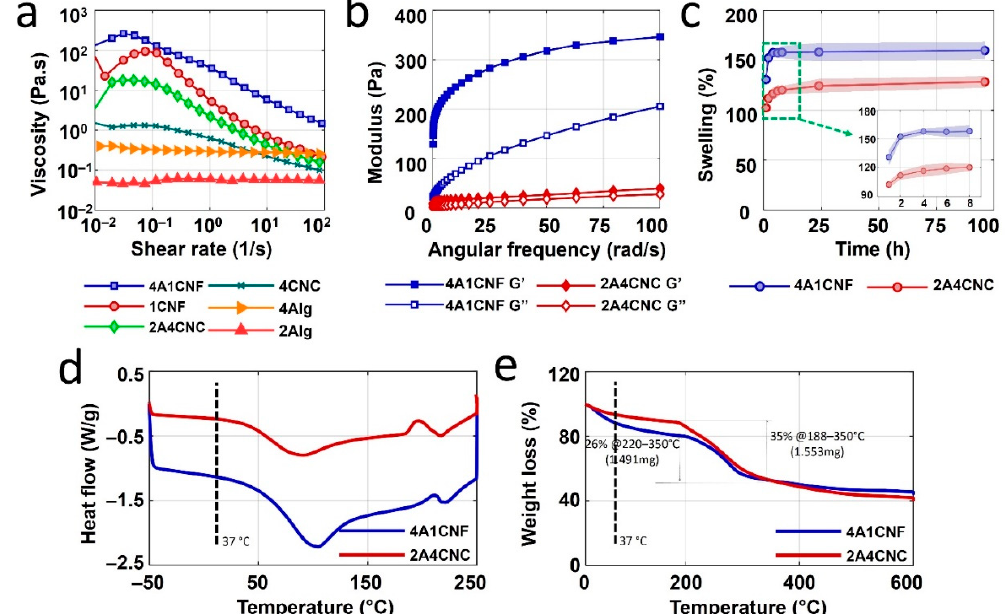
Figure 3. Rheological and thermal characterization of bioinks. ( a ) The viscosity of two hybrid bioinks formulation (4A1CNF, 2A4CNC) and their separate components (4A, 1CNF, 2A, and 4CNC) as a function of shear rate. ( b ) Storage modulus (G’) and loss modulus (G’’) of two bioink formulations (4A1CNF and 2A4CNC). ( c ) Swelling (water absorbance) of dried patches made with these two bioinks over up to 96 h. Differential scanning calorimetry (DSC) analysis results ( d ) and thermogravimetric analysis (TGA) results ( e ) of freeze-dried 4A1CNF and 2A4CNC samples.